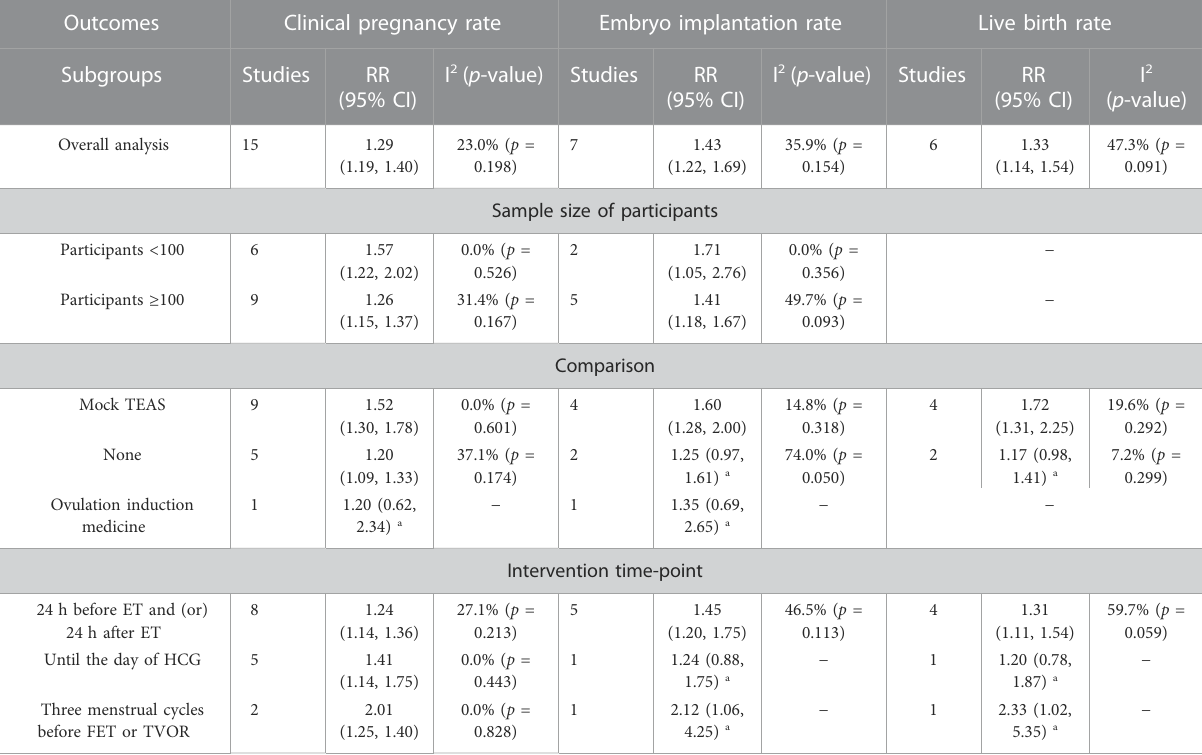
TABLE 2 Subgroup analyses of Clinical pregnancy rate, Embryo implantation rate and Live birth rate. Outcomes Clinical pregnancy rate Embryo implantation rate Live birth rate Subgroups Studies RR I 2 ( p -value) Studies RR I 2 ( p -value) Studies RR I 2 (95% CI) (95% CI) (95% CI) ( p -value) Overall analysis 15 1.29 (1.19, 1.40) Sample size of participants